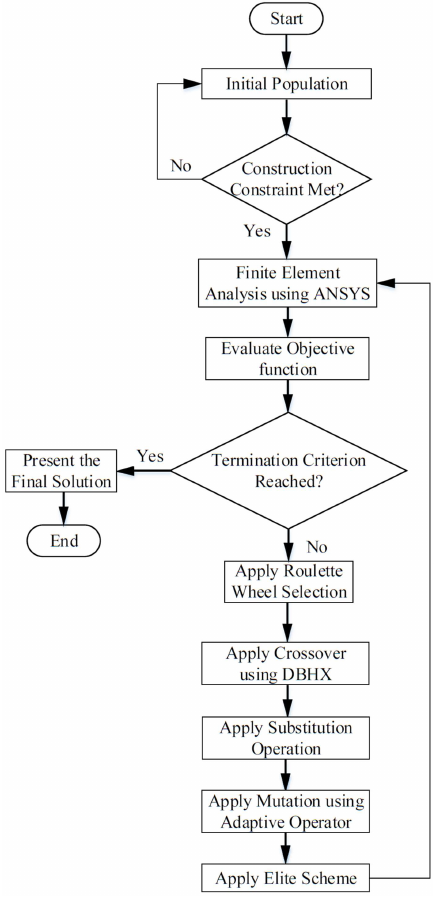
Figure 3. Flow chart of optimization of steel frame with SPSWs by IGA.